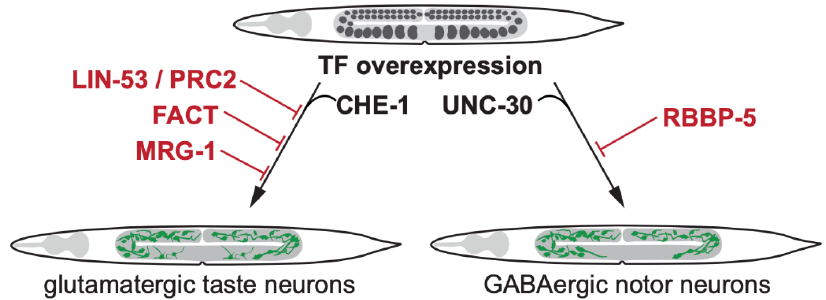
Figure 2. Transcription factor-induced germ cell reprogramming to somatic fates. Loss of the histone chaperone LIN-53 allows direct reprogramming of germ cells into glutamatergic taste neurons (known as ASE) by the Zn-finger TF CHE-1 [7]. LIN-53 cooperates with the Poly Comb Repressive Complex 2 (PRC2) to safeguard germ cells from being reprogrammed by TFs [17]. The heterodimeric histone chaperone FACT [28] and the chromodomain protein MRG-1 block germ cell conversion to glutamatergic neurons [35]. The Set1 / MLL methyltransferase complex member RBBP-5 blocks UNC-30 TF-induced germ cell reprogramming to GABAergic neurons [40].